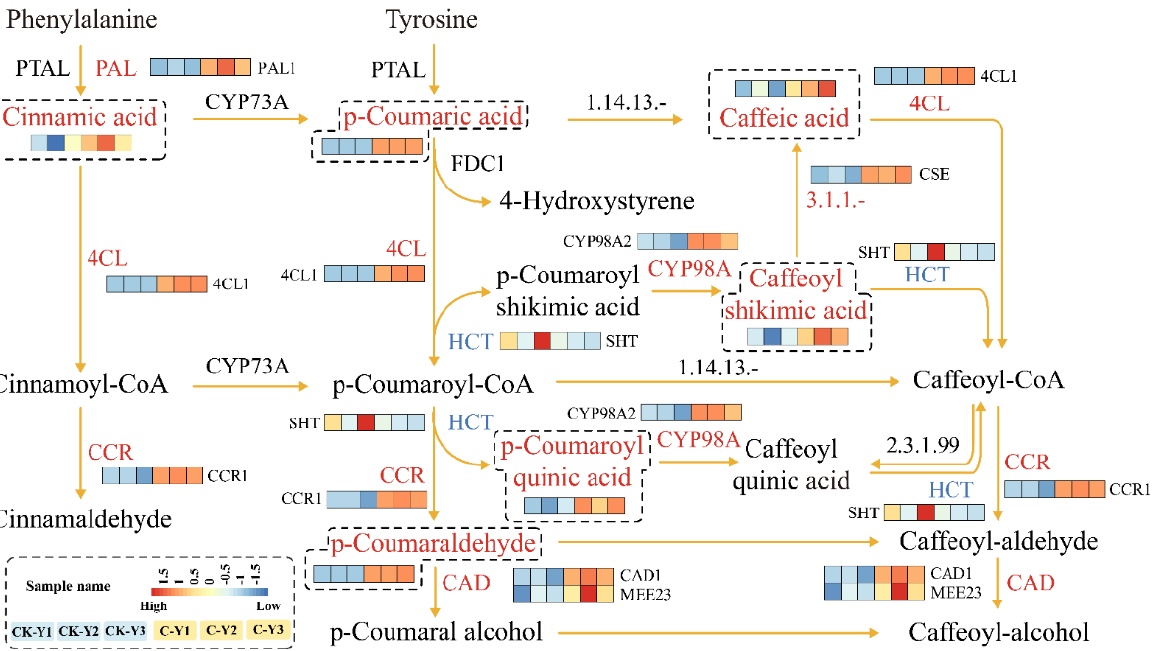
Figure 10. A Schematic Diagram Developed from the Integration of Differentially Expressed Genes (DEGs) and Differentially Accumulated Metabolites (DAMs) in the Phenylpropanoid Pathway in Leaves. Three biological control leaf samples (CK-Y1, CK-Y2, and CK-Y3) and three biological treated leaf samples (C-Y1, C-Y2, and C-Y3) are coded by three squares or rectangles in the order of CK-Y1, CK-Y2, CK-Y3, C-Y1, C-Y2, and C-Y3. The six squares or rectangles were used to create heatmaps. The expression levels of genes and accumulation levels of metabolites in C-Y1, C-Y2, C-Y3, C-Y1, C-Y2, and C-Y3 are coded by colored heatmaps of the six squares or rectangles. PAL, 4CL, CCR, CYP98A, and CAD coded with a red color on each arrow mean that their gene expression levels are upregulated in the treated leaves. HCT coded by a light blue means that its gene expression is reduced. Six metabolite names, which are coded with a red color at end of arrows and included together in a heatmap contained in a dashed box, mean that their levels are increased in the treated leaves.